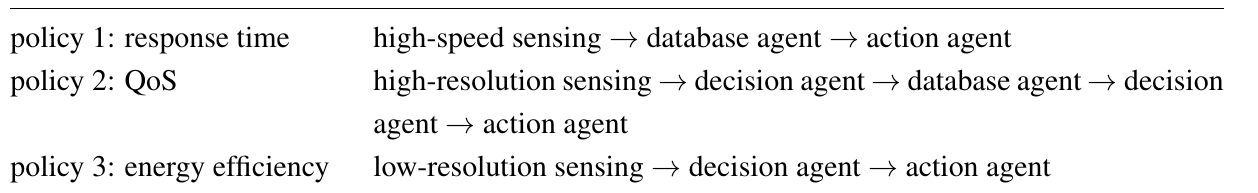
Table 3. Regulation policies and agent interaction protocol designs. QoS, quality of